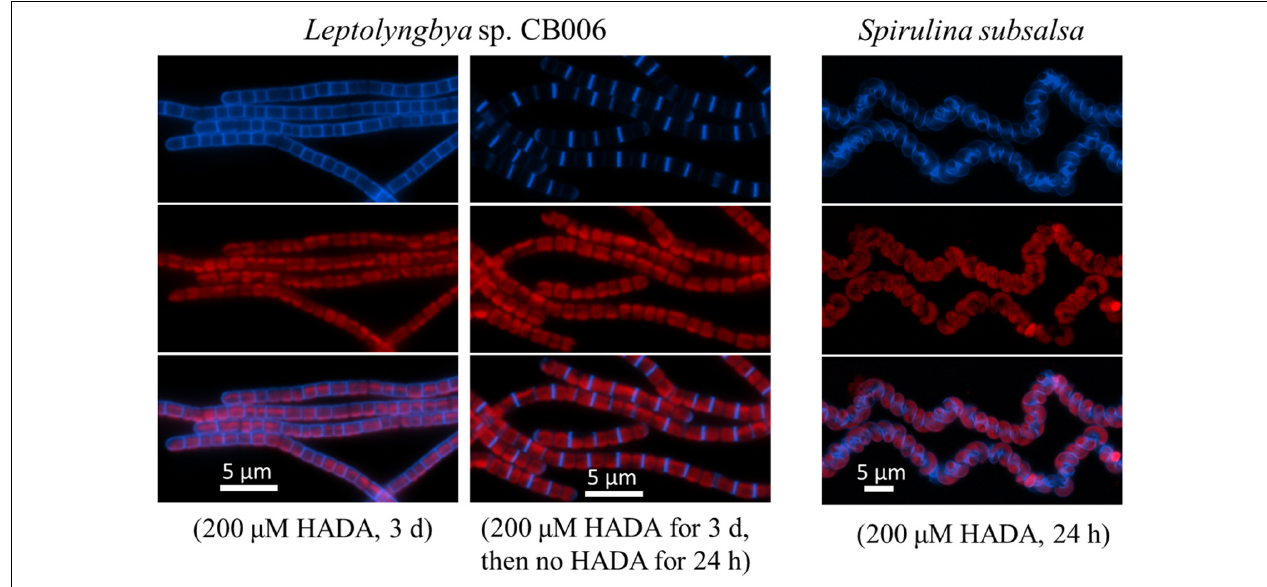
FIGURE 3 | HADA incorporation into Leptolyngbya sp. CB006 and Spirulina subsalsa . Leptolyngbya requires a longer incubation time with HADA. Photos of HADA fluorescence (blue), photosynthetic pigment fluorescence (red), and their merges are shown.